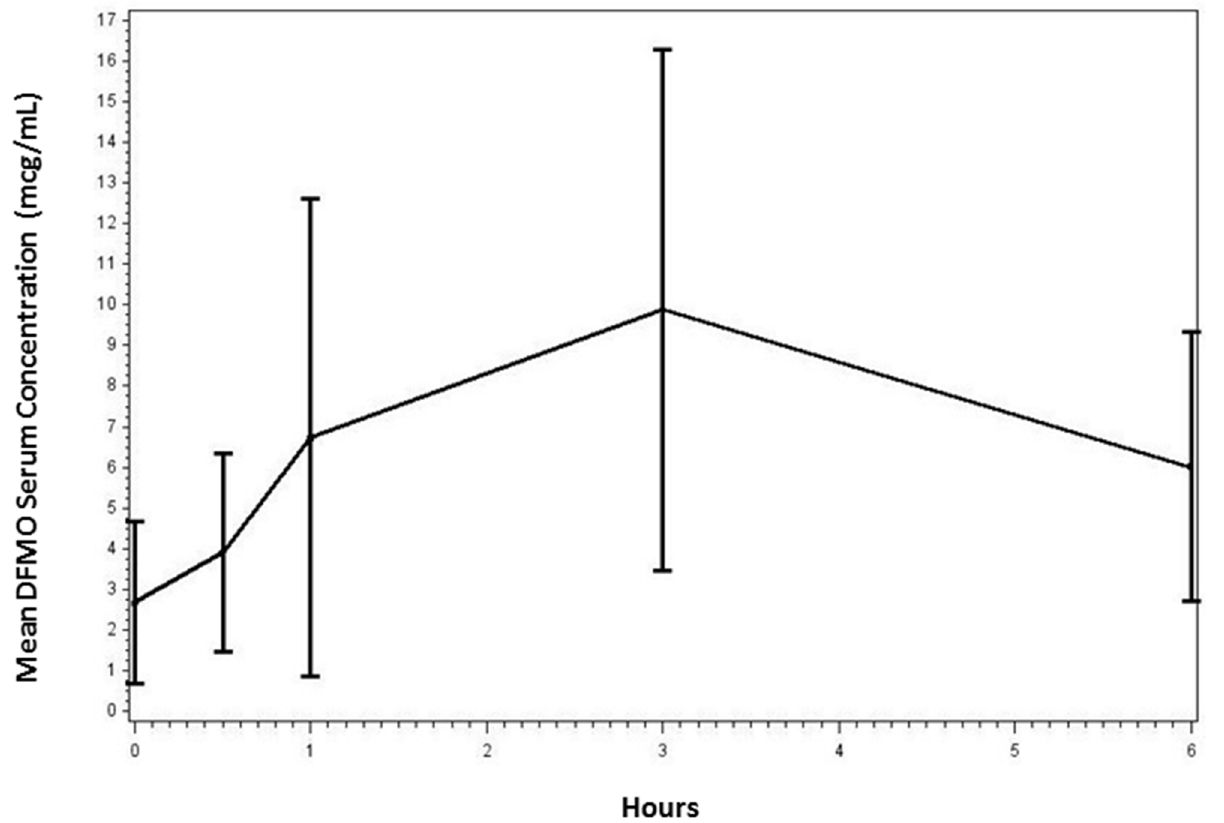
Fig 3. Serum DFMO concentration versus time measurements for three patients receiving 750 mg/m 2 PO BID during cycle 1 of therapy.